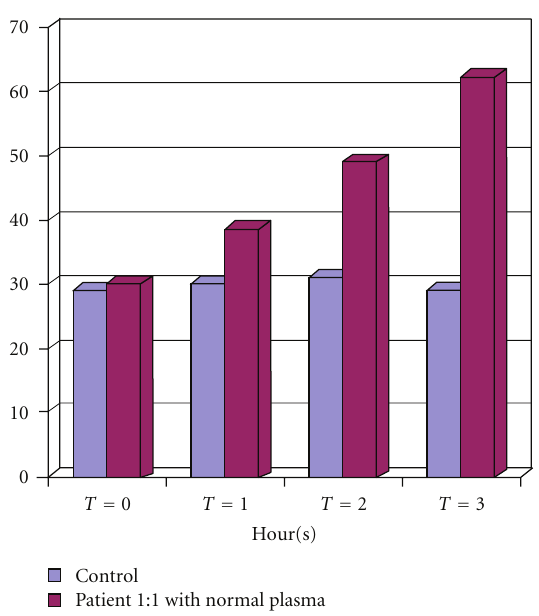
Figure 1: APTT with time in control and patients plasma mixed 1:1 with normal